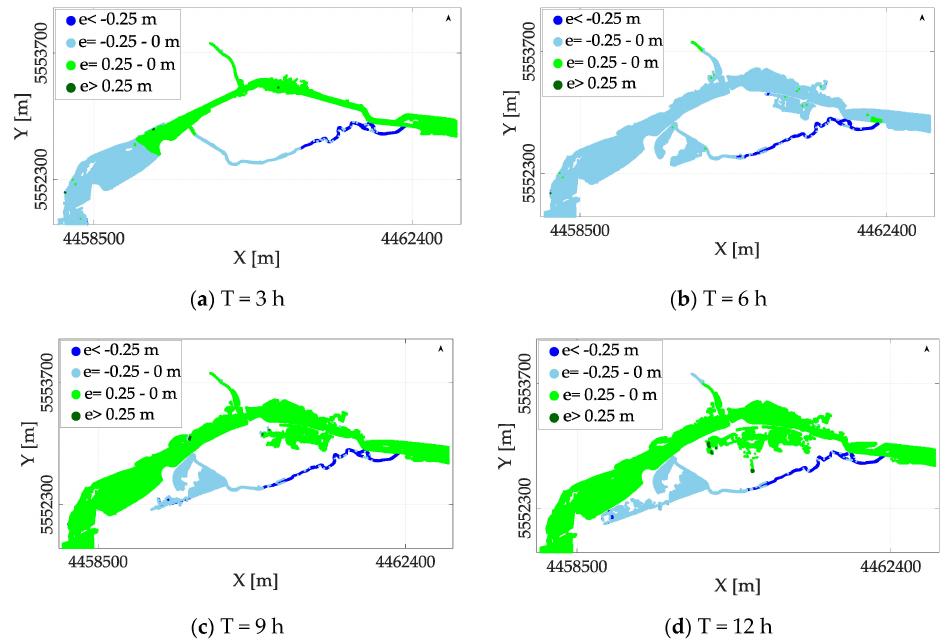
Figure 9. Water depth error between offline and online maps for May 2006. Positive values indicate over-prediction and negative values indicate under-prediction: ( a ) T = 3 h, ( b ) T = 6 h, ( c ) T = 9 h and ( d ) T = 12 h.